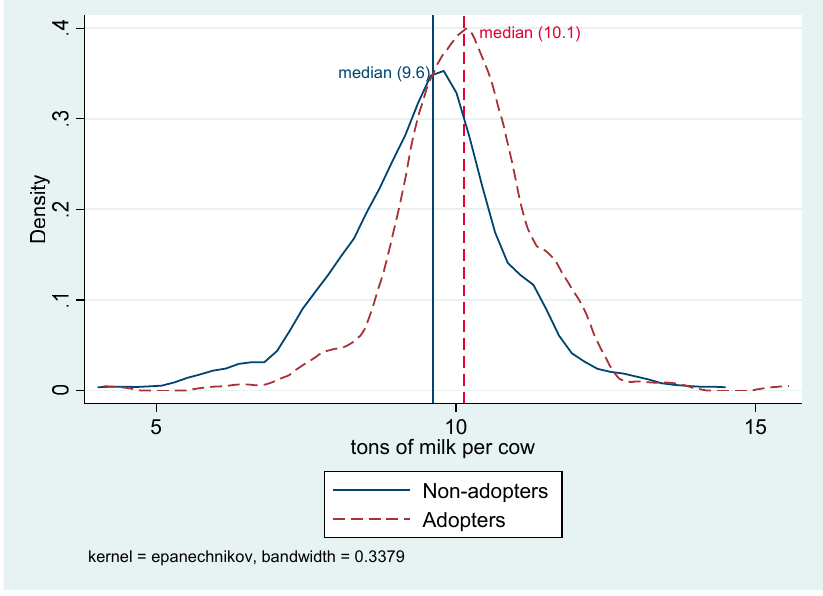
Figure 3. Kernel density estimate of milk production. Source: Our elaborations on survey.